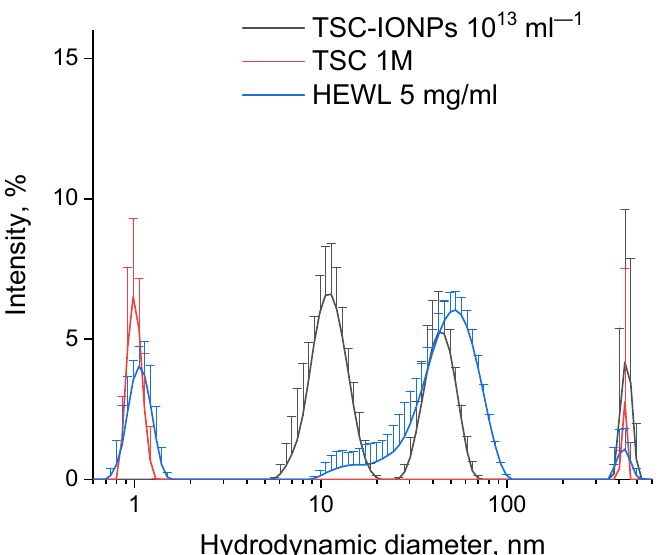
Figure 1. Distribution (weighted by intensity) of hydrodynamic diameters of molecules, clusters, and aggregates for TSC-IONPs 10 13 mL − 1 , TSC 1 M, and HEWL (5 mg/mL) solution without NPs and TSC. Polydispersity index for TSC-IONPs 0.34 ± 0.15 (mean ± SD), for TSC 0.68 ± 0.16, and for HEWL 1.03 ± 0.17.